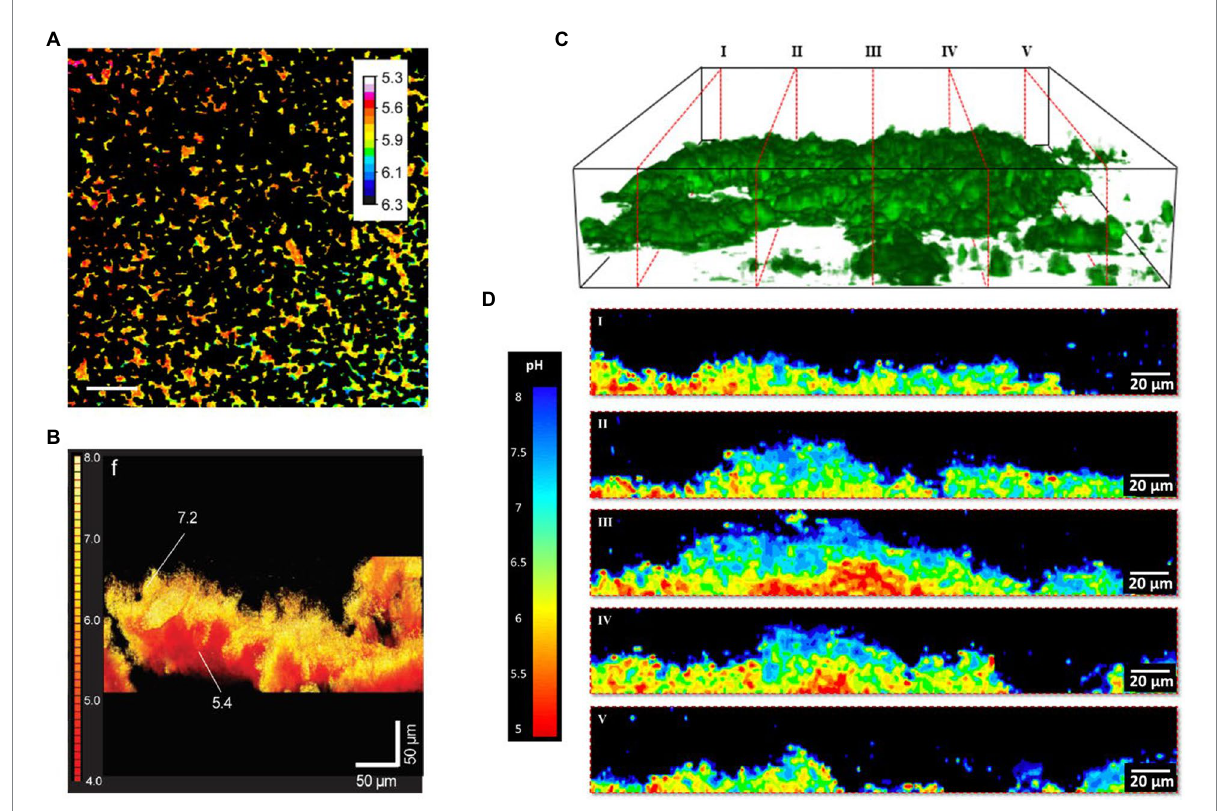
FIGURE 7 pH variation in biofilms measured via fluorescence. (A) Extracellular pH landscape in the model biofilm exposed to sterile saliva with 0.4% (w/v) glucose and C-SNARF-4 (pH-sensitive ratiometric probe). The scale bar represents 20 μ m (Schlafer et al., 2011). (B) Functional 3-D tomographic imaging of side volumetric projections of the reconstructed biofilm pH map of E. coli (Hidalgo et al., 2009). (C) Representative 3D CLSM reconstruction of axial pH distribution within intact microcolony of P. fluorescens biofilms, showing orthogonal slices I-V (Fulaz et al., 2019). (D) Corresponding ratiometric orthogonal slices from (C) showing spatially distinct pH gradients in the y, z direction within microcolonies of P. fluorescens biofilms. Scale bars represent 20 μ m (Fulaz et al., 2019). These figures were reproduced with permission from Schlafer et al. (2011), Hidalgo et al. (2009), and Fulaz et al.